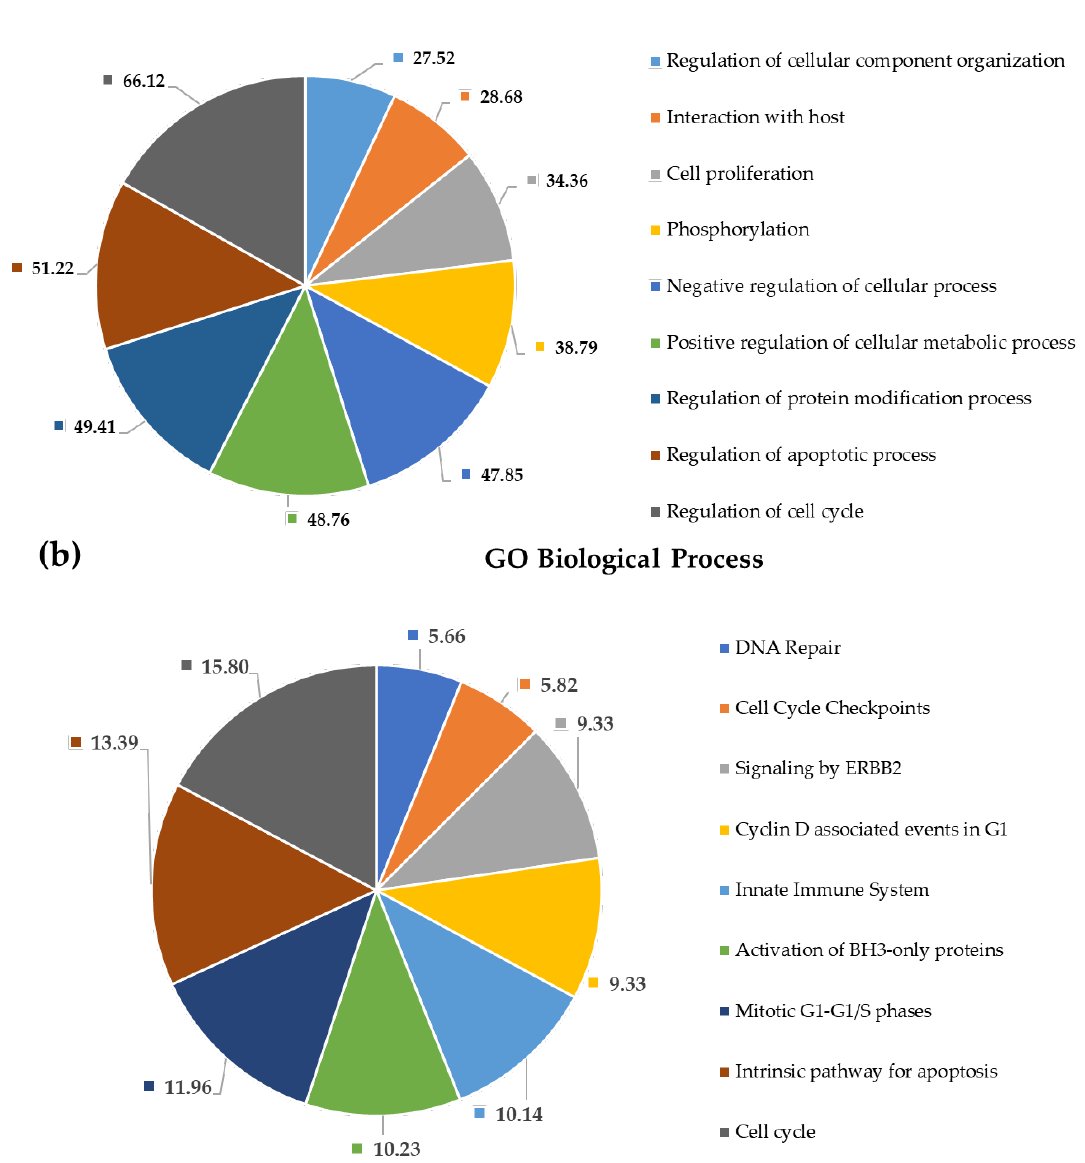
Figure 8. GO biological process–based general ( a ) and cortex-specific ( b ) functional enrichment annotation of all target genes of differentially expressed miRNAs applying the NetworkAnalyst tool. Significance of the selected (?) pathways are characterized by their FDR values shown inside the chart sections.